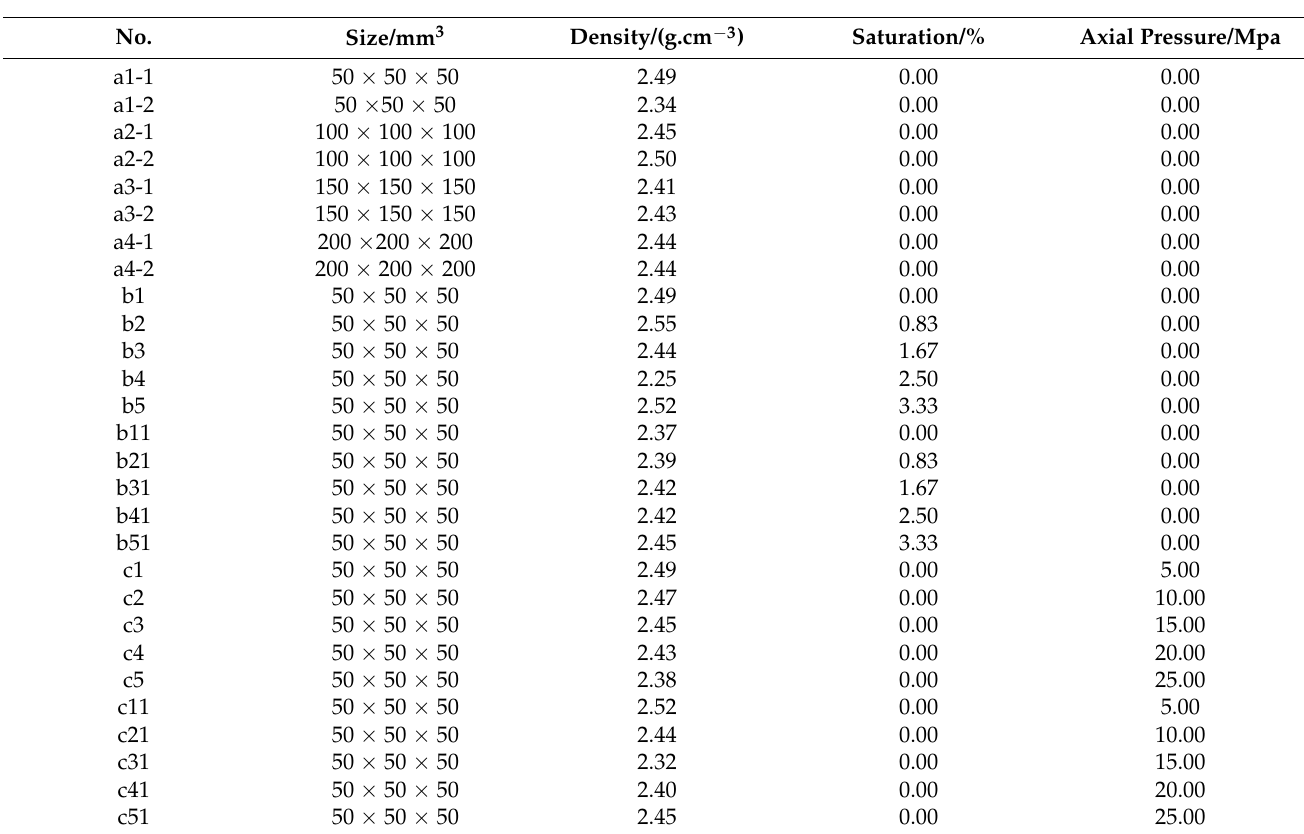
Table 1. Basic parameters of sandstone samples and experiment